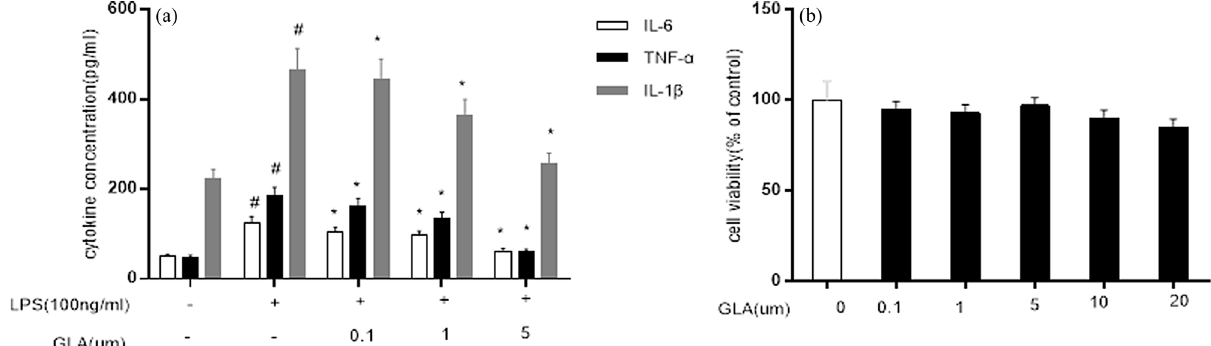
Figure 10: E ff ects of GLA on pro - in fl ammatory cytokine production and cellular viability. ( a ) Production of TNF - α , IL - 6, and IL - 1 β in the LPS - stimulated RAW264.7 cells, in the presence or absence of GLA ( at indicated concentrations ) was detected with ELISA. ( b ) Cell viability of the LPS - induced macrophage RAW264.7, treated with GLA ( at indicated concentrations ) , was detected with the MTT assay. Compared with the SAL group, # P < 0.05; and compared with the LPS - treated group, * P < 0.05. N = 3; analyzed by ANOVA.